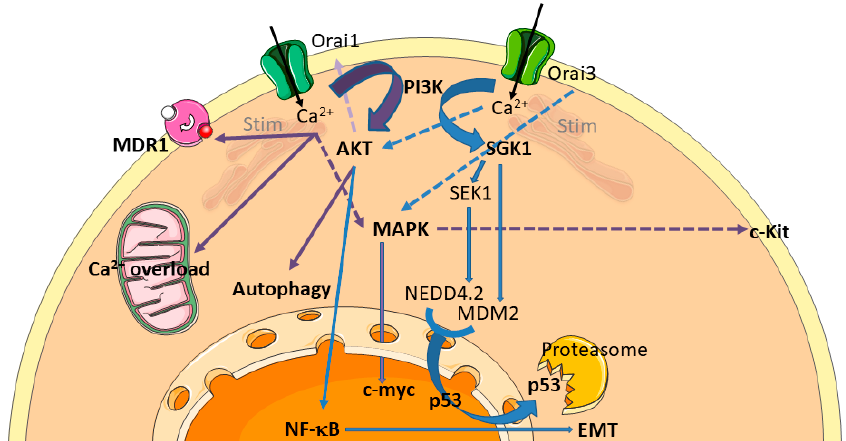
Figure 1. Chemoresistance pathways involving Orai calcium channels. Orai calcium channels are able to modulate sensitivity to chemotherapy. Processes known to alter chemoresistance are highlighted in bold. These include calcium overload, MultiDrug Resistance (MDR), autophagy, modulation of signalling pathways (MAPK and PI3K-Akt/Sgk), transcription factors (NF- κ B, c-myc, p53), and EMT (Epithelial to Mesenchymal Transition). Processes initiated by Orai1 and Orai3 are summarized by purple and blue arrows, respectively. The dashed arrows are not different from plain arrows, except that they cross other arrows.